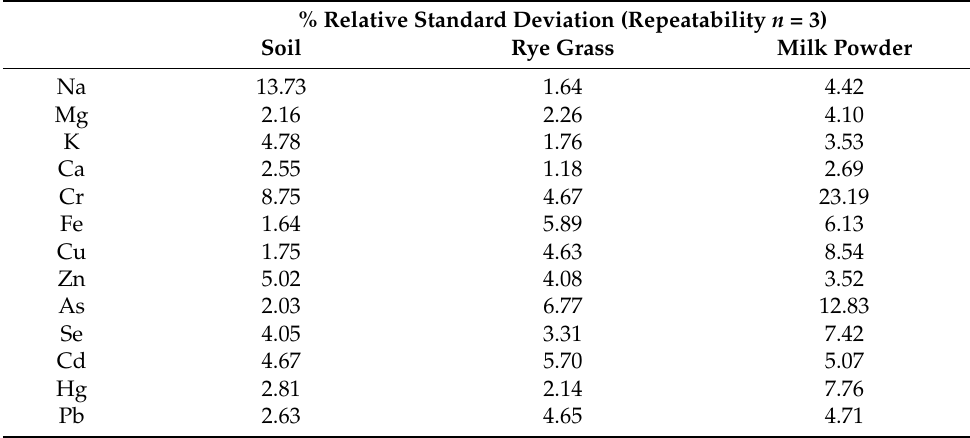
Table A4. Relative standard deviation (RSD) values of soil, ryegrass, and milk